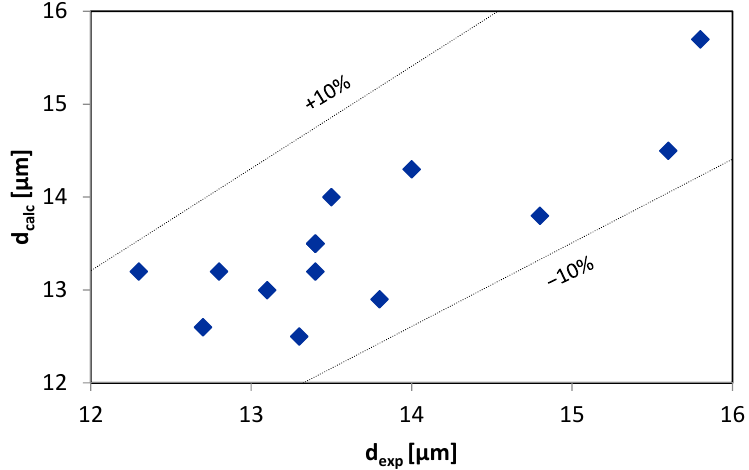
Figure 7. Comparison of measured and predicted by the FLMill model mean Sauter diameter of grinding product.